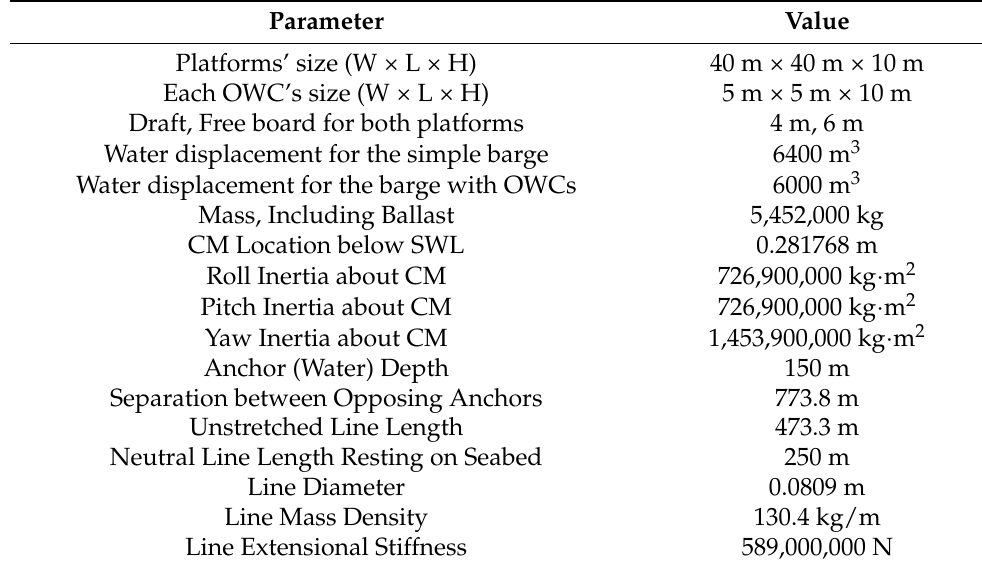
Table 2. Standard barge and the 4OWC-based barge platforms’